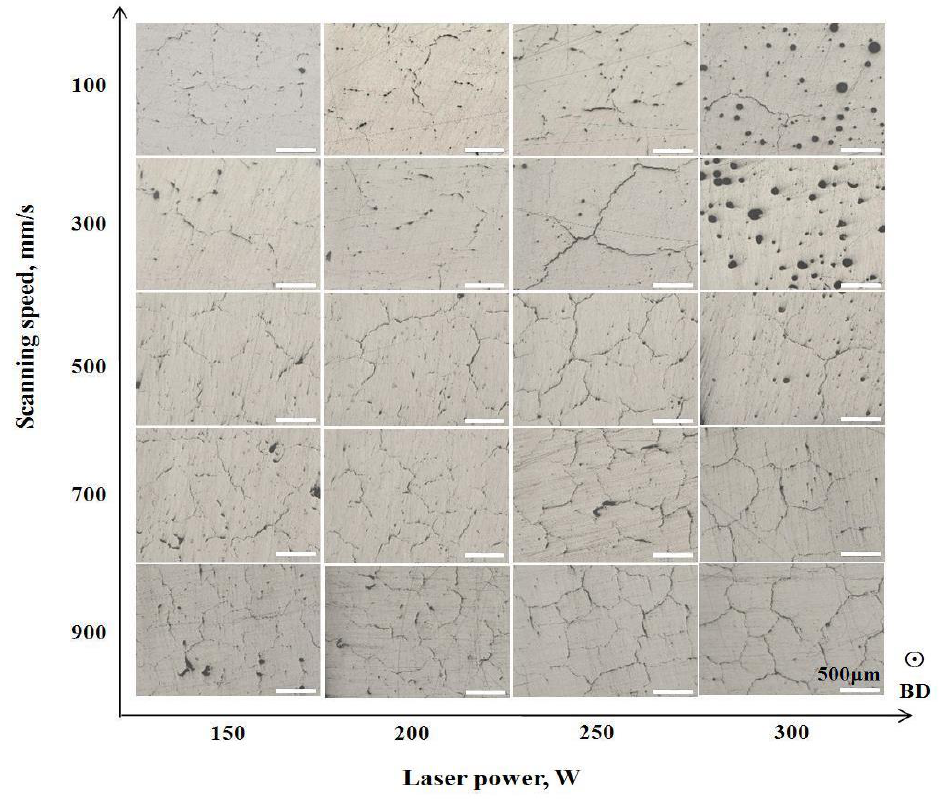
Figure 3. The microstructure of SLM-printed horizontal samples without supports at various laser powers and scanning speeds.